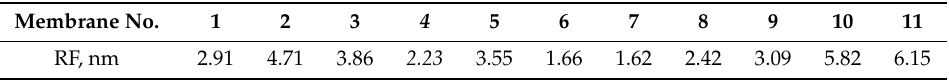
Table 4. Mean roughness (RF) of